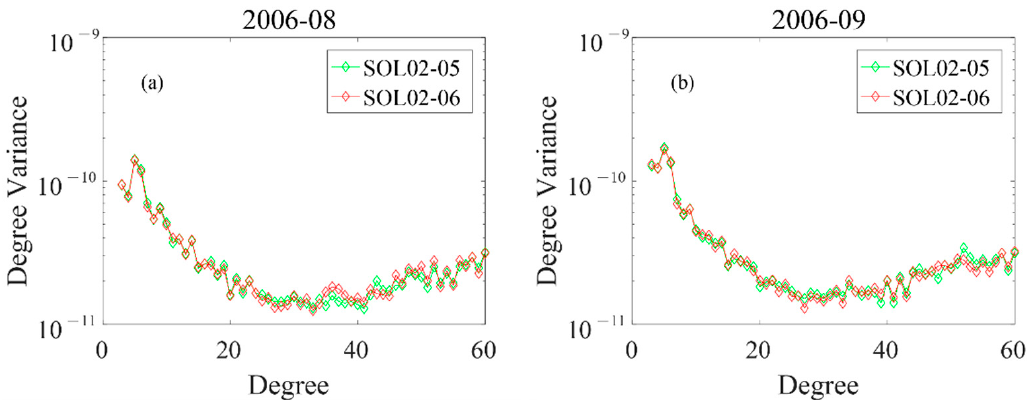
Figure 8. Comparison of degree variances of monthly gravity field models using AOD1B RL05 and RL06 models, which are represented SOL02-05 and SOL02-06, respectively. ( a ) SOL02 in August 2006; and ( b ) SOL02 in September 2006.